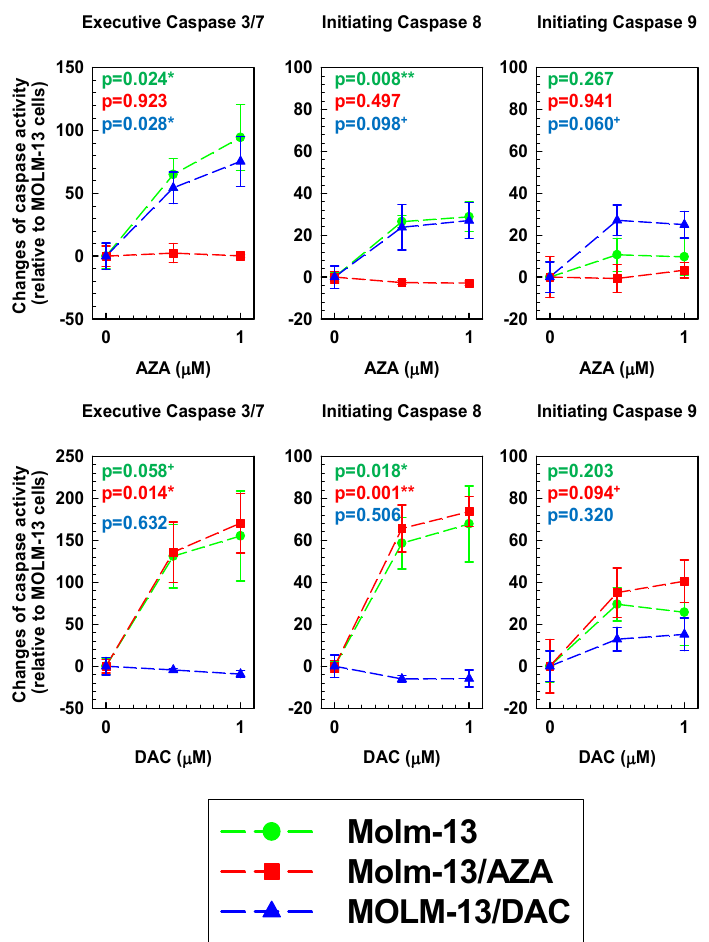
Figure 9. Activity of executive caspase 3/7 and initiating caspase 8 and 9 in the MOLM-13, MOLM- 13/AZA and MOLM-13/DAC cells after 72 h in culture in the absence or presence of either AZA or DAC at given concentrations. The data (mean ± SD) of three independent measurements are expressed as percentages representing the difference between the respective value and the value ob- tained for the same cell variant cultured in the absence of both hypomethylating agent (HMAs). The level of probability (calculated using ANOVA one-way analysis of variance); p < 0.01 (**), p < 0.05 (*) and p < 0.1 (+) were considered highly significant, moderately significant and marginally signif- icant, respectively.